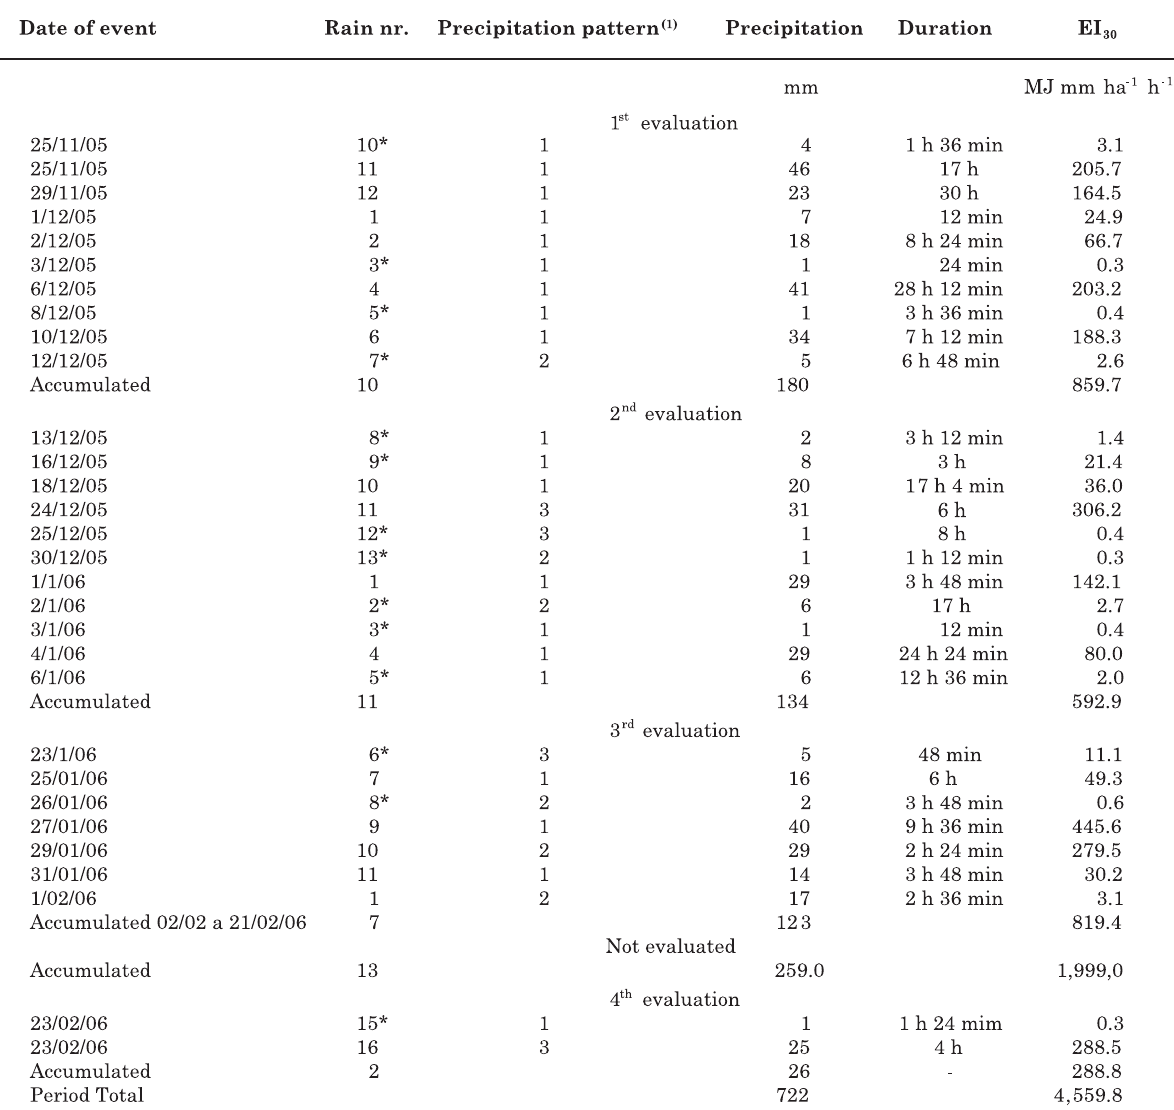
Table 3. Characteristics of erosive and non- erosive rains in Pinheiral between 11/25/05 and 2/23/06, as found by means of Chuveros software